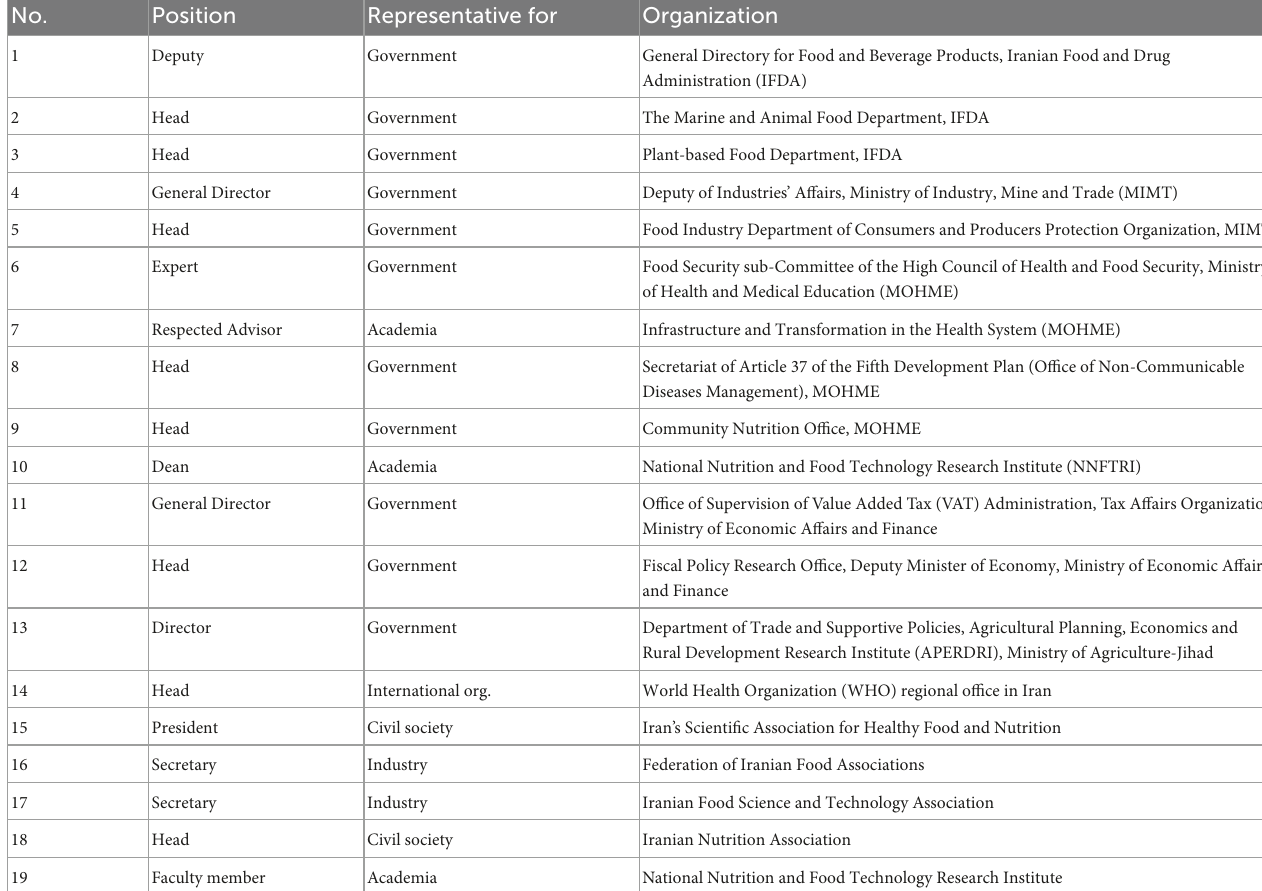
TABLE 1 General characteristics of the participants in the interview